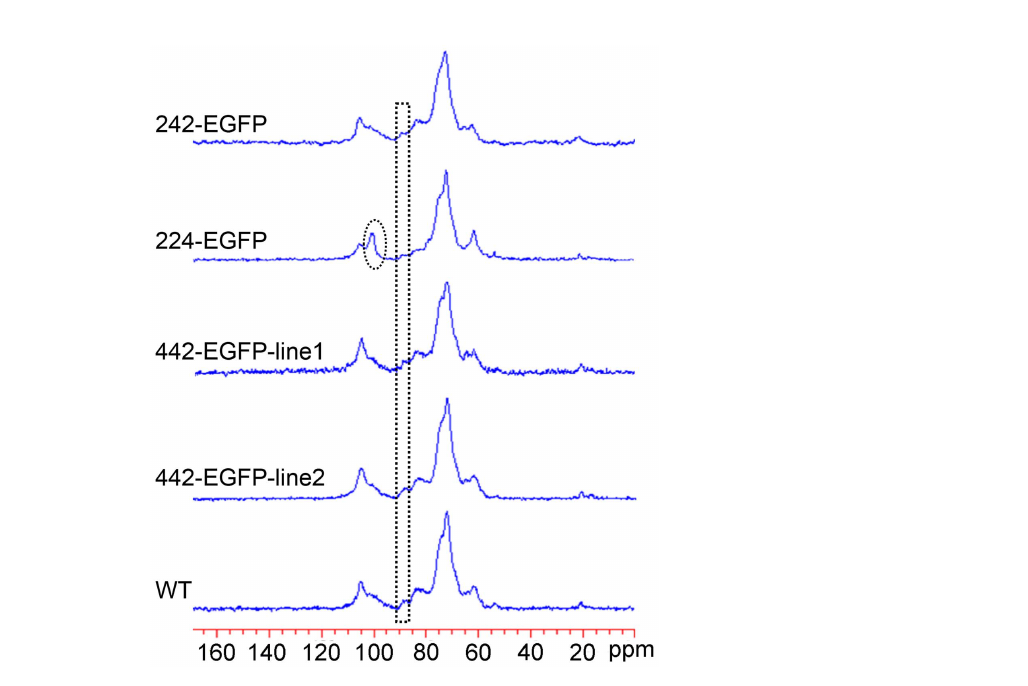
Fig. 6. Solid state one dimensional 13 C NMR spectra of walls of transgenic cells versus WT walls. The chemical shifts and relative signal intensities of anomeric carbons (i.e., C 1 ) of glucosyl residues of cellulose in 242-EGFP and 442-EGFP cell walls were comparable to those of wild type cell walls. However, 224-EGFP cell walls displayed much stronger signals of anomeric 13 C of xylosyl residues (oval) and lower signal of crystalline cellulose